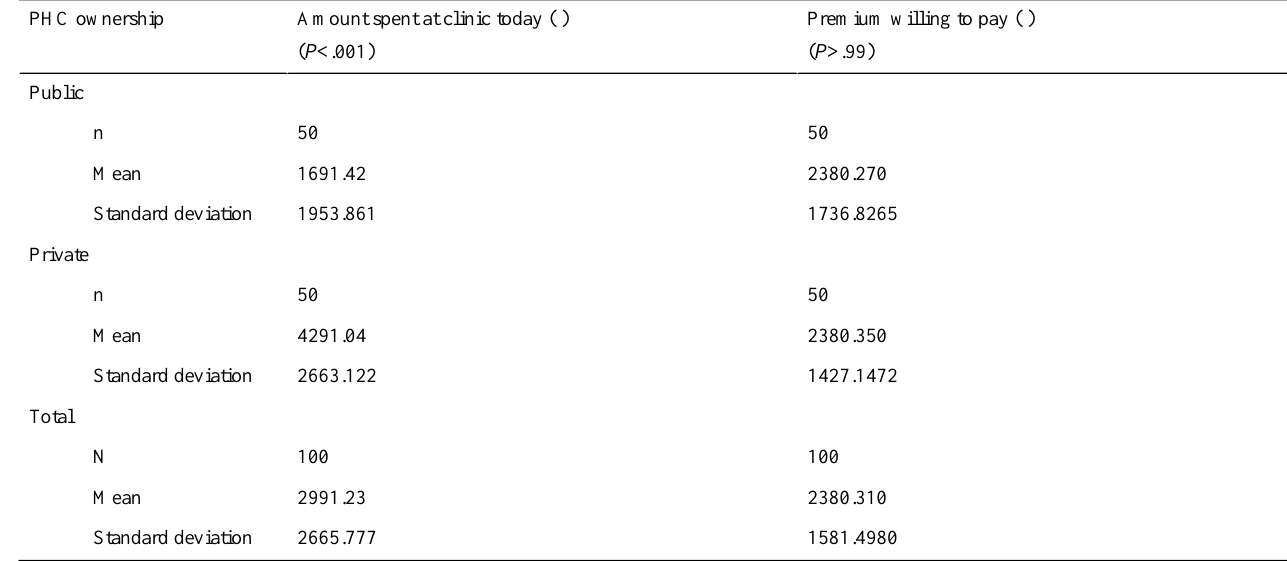
Table 4. Amount spent for health service on clinic visit